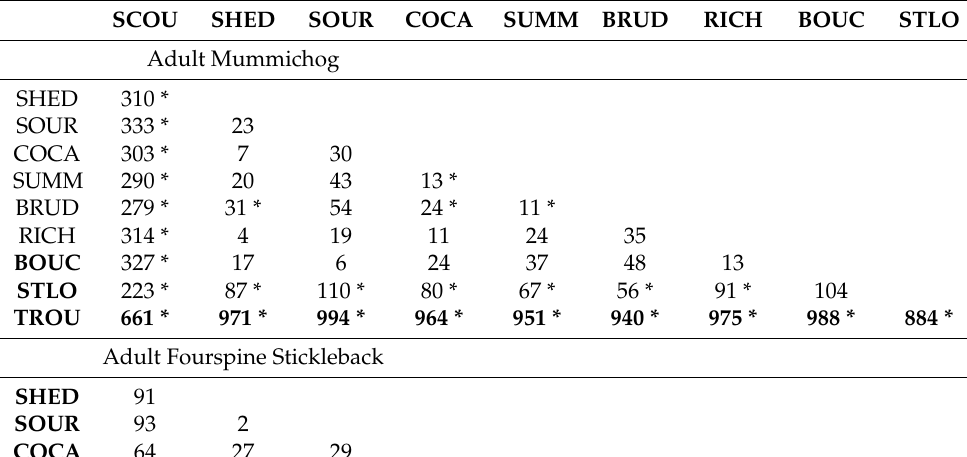
Table 8. The differences in mean influential species counts between